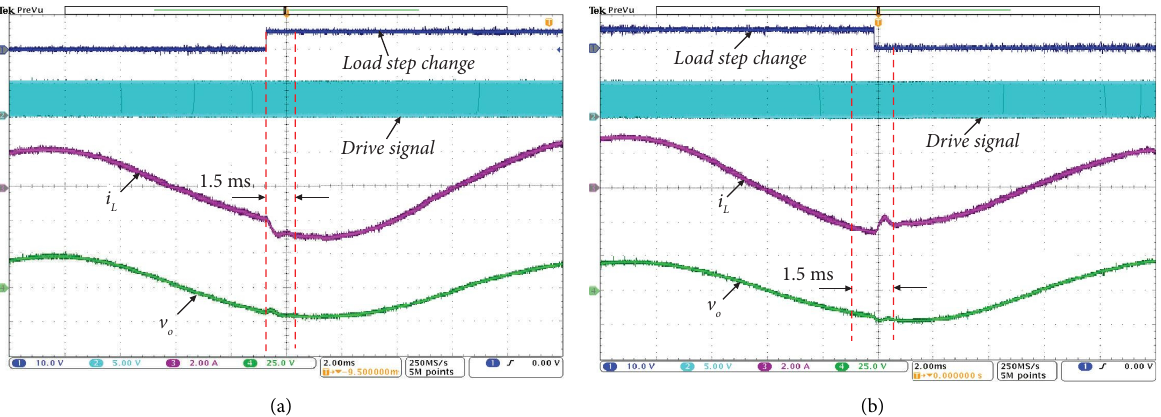
Figure 17: Transient waveforms with the PI controllerat 4 π /3. (a) Step change of i to 2.2